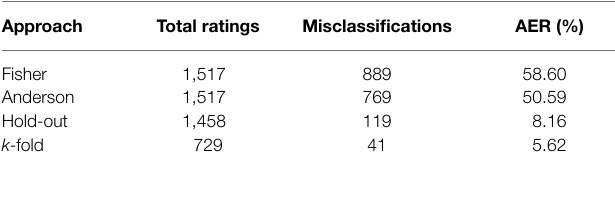
TABLE 2 | Classification of soybean genotypes into 11 populations of different relative maturity groups and estimation of apparent error rate (AER) according to Fisher’s and Anderson’s discriminant analysis and hold-out and k -fold ANN approaches.